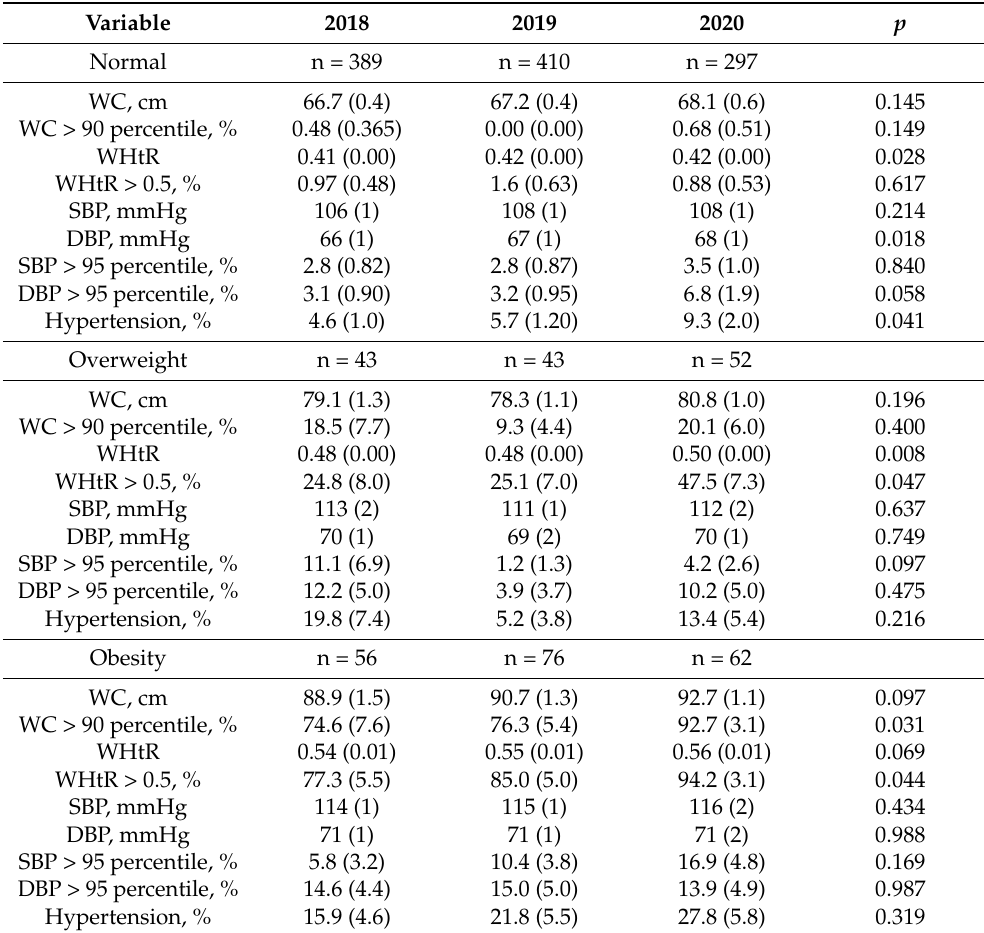
Table 4. Proportion of participants with obesity, abdominal obesity, and hypertension according